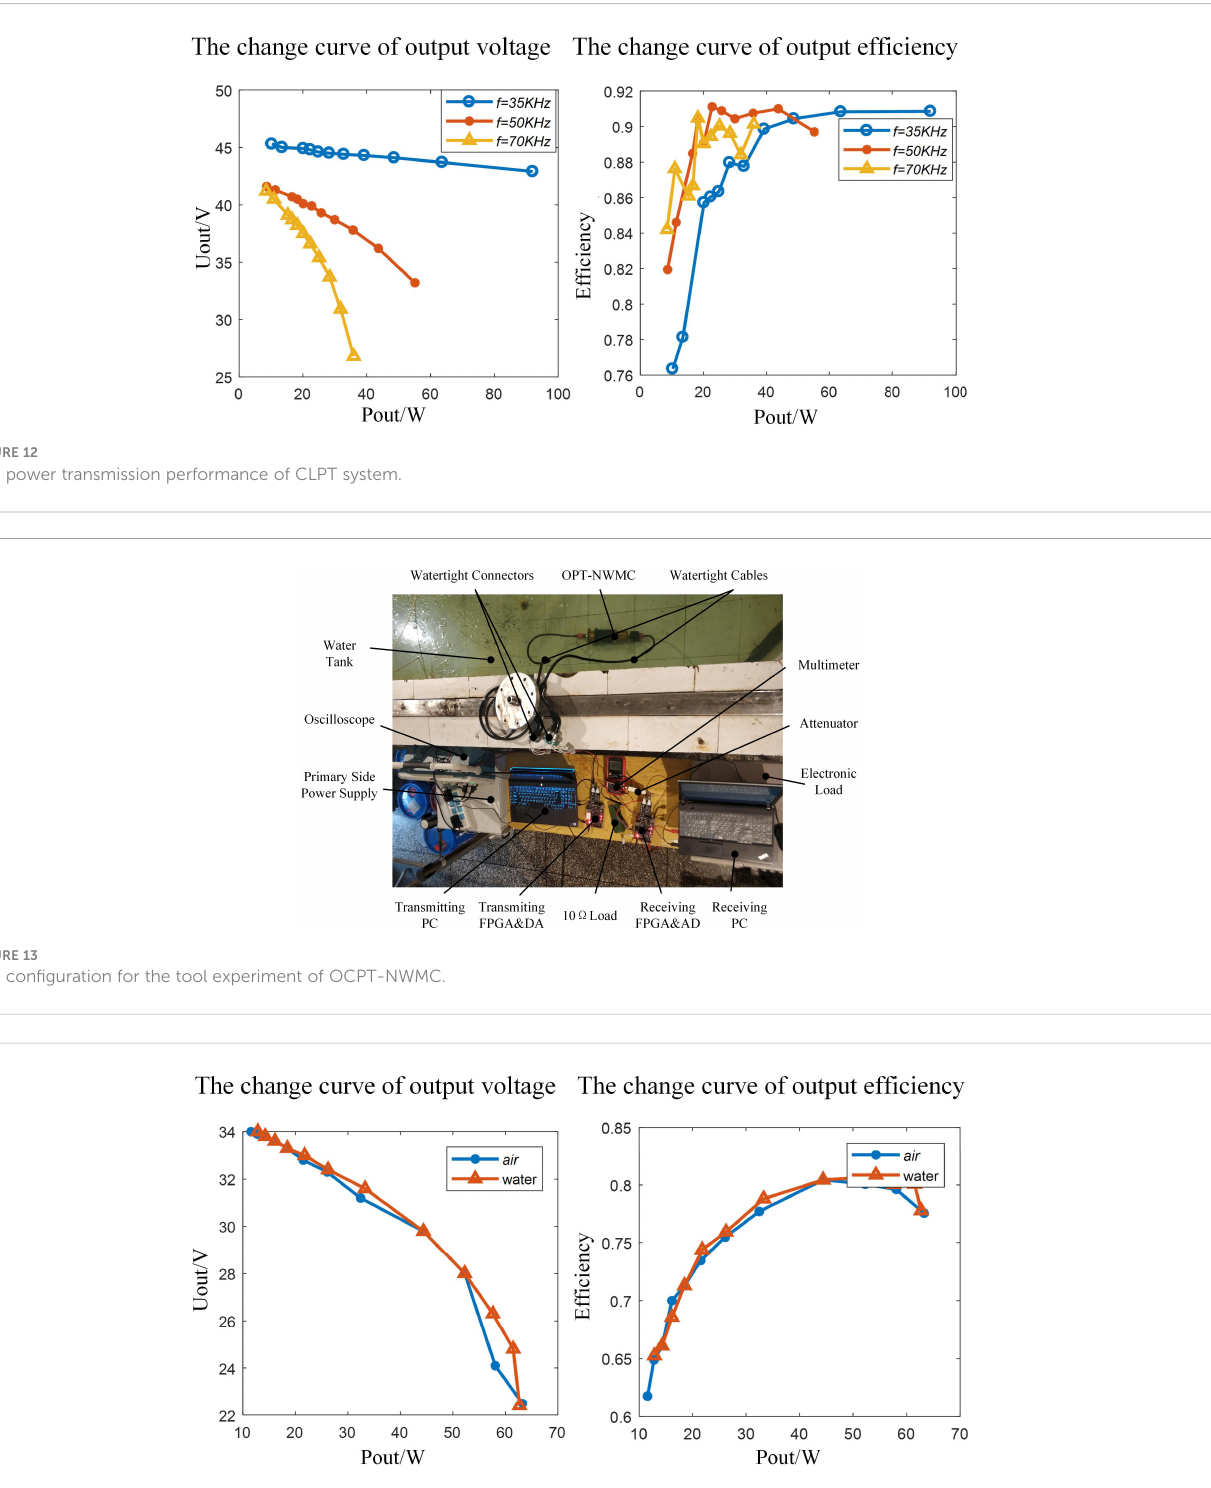
receiver. In order to test the bandwidth of the communication system, square waves with an amplitude of 1Vp-p at different frequencies were sent at the transmitting side. And the output of the transimpedance ampli fi er at the receiving side was connected to an oscilloscope to check the amplitude and phase of the received signal. The amplitude-frequency response of the system obtained is shown in